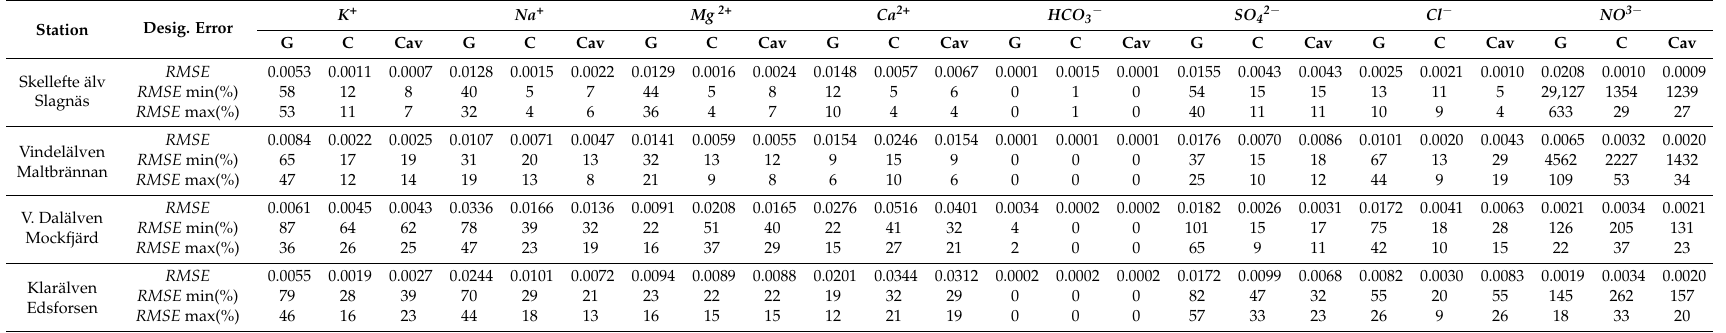
Table 7. Error measures, the root mean square error ( RMSE ), the root mean square error compared to the minimum measured value of the concentration as a percentage ( RMSE min), and the root mean square error related to the maximum measured value of the concentration as a percentage ( RMSE max) obtained from comparing modeled and measured values of the concentration at the four stations employed to validate the